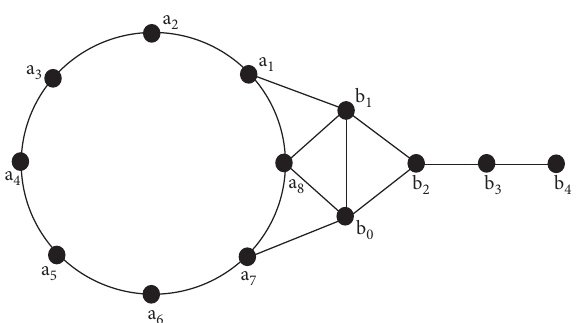
Figure 5: Paraline graph of dragon graph L ( L ( T